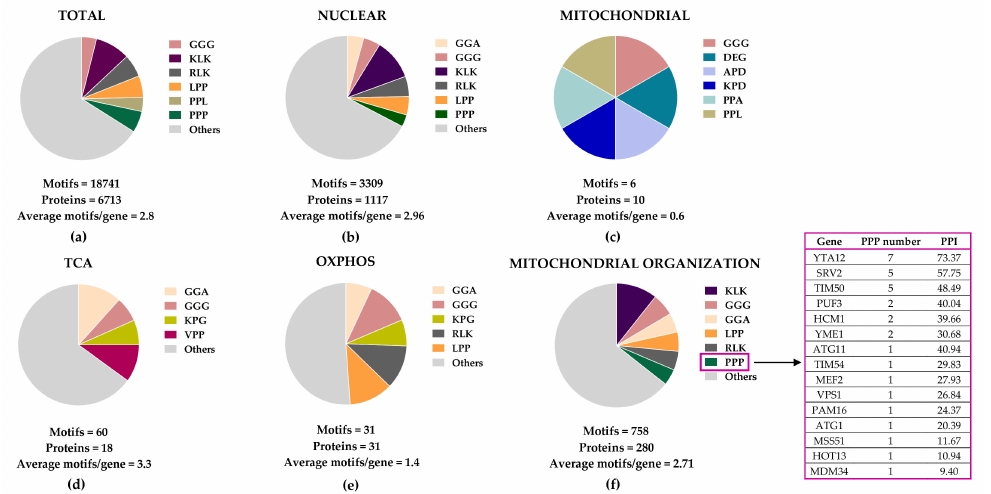
Figure 2. Distribution of eIF5A-dependent motifs in Saccharomyces cerevisiae mitochondrial pro- teins. Distribution of the 43 highest-scoring eIF5A-dependent ribosome-pausing tri-peptide mo- tifs [11] in the proteins of the whole yeast genome ( a ), nuclear-encoded mitochondrial proteins ( b ), mitochondrial-encoded proteins ( c ), the tricarboxylic acid (TCA) cycle ( d ), oxidative phosphorylation (OXPHOS) ( e ), and in the mitochondrial organization Gene Ontology functional category ( f ). The table shows the proteins involved in mitochondrial organization with at least one PPP motif. The protein pause index (PPI) is calculated as the sum of the quantitative value of the ribosome pause provoked by depletion of eIF5A in each of the 43 highest eIF5A-dependent tri-peptide motifs [11] found in the amino acid sequence of each protein, and is higher in proteins that are putatively more dependent on eIF5A for their